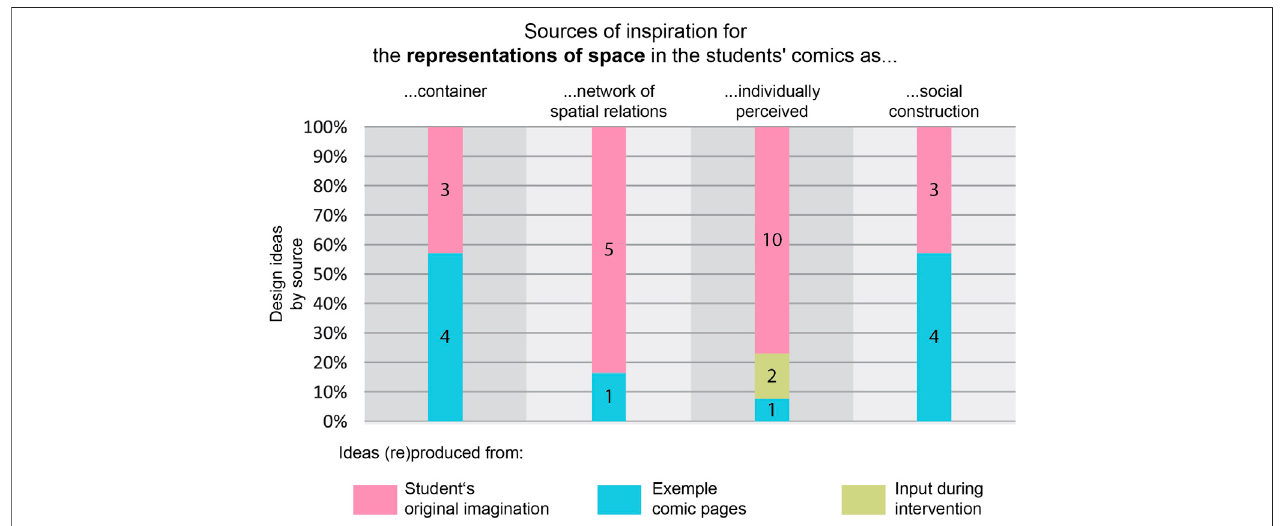
FIGURE 4 | Creation (pink) and reproduction (blue and green) of ideas by the participants for the representations of space in their own comics. N (cid:1)